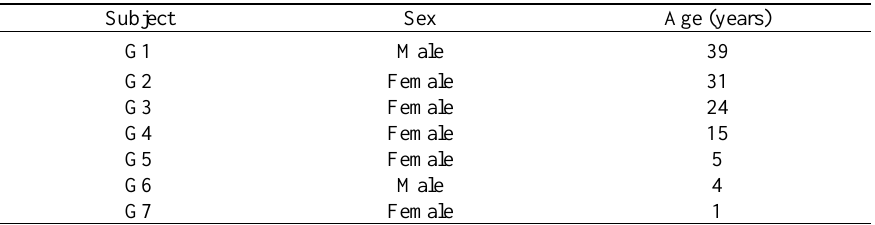
Subjects of the Current Study, Including Sex and Age at the Time of the Study Subject